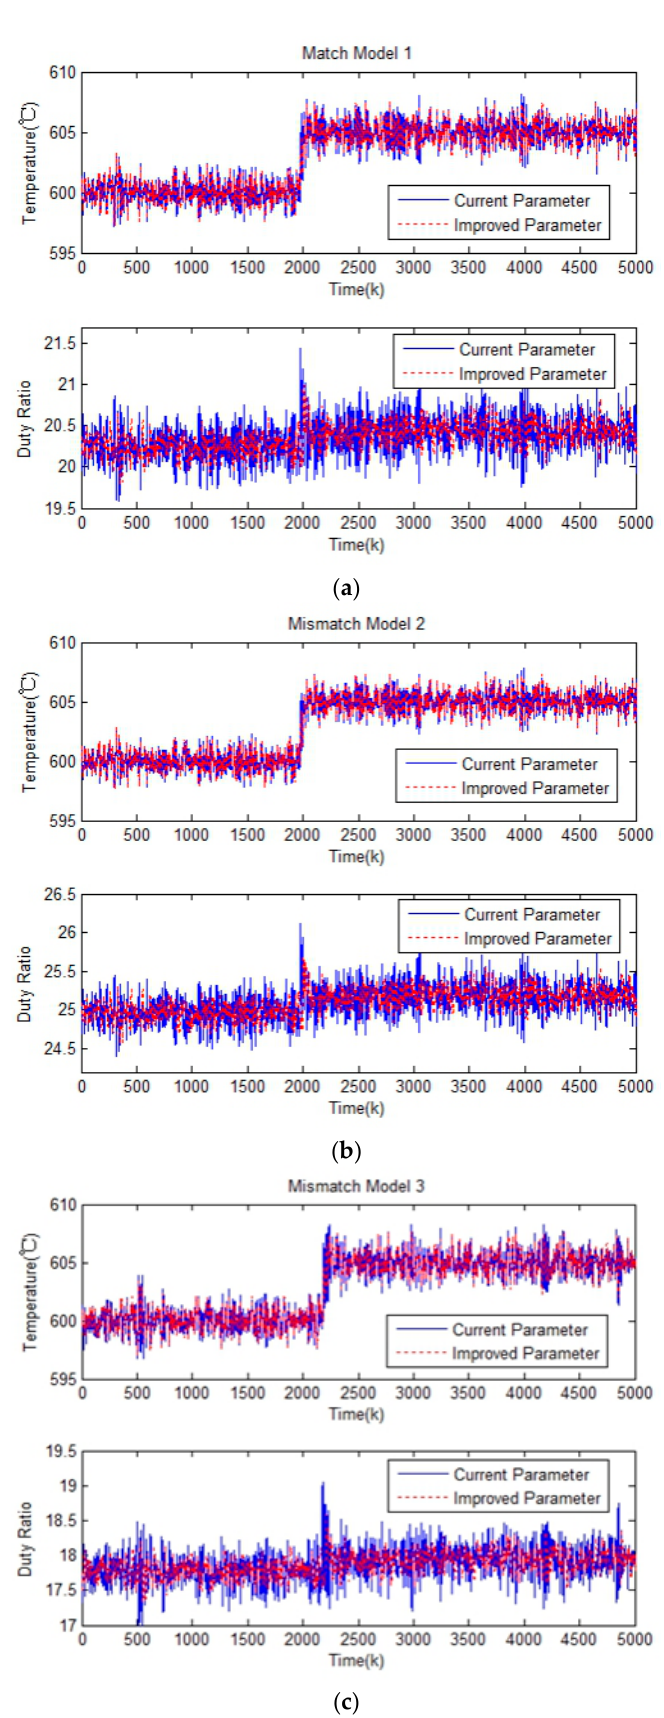
Figure 7. ( a ) A comparison of the improved parameter and the current parameter (Model 1) . ( b ) A comparison of the improved parameter and the current parameter (Model 2). ( c ) A comparison of the improved parameter and the current parameter (Model